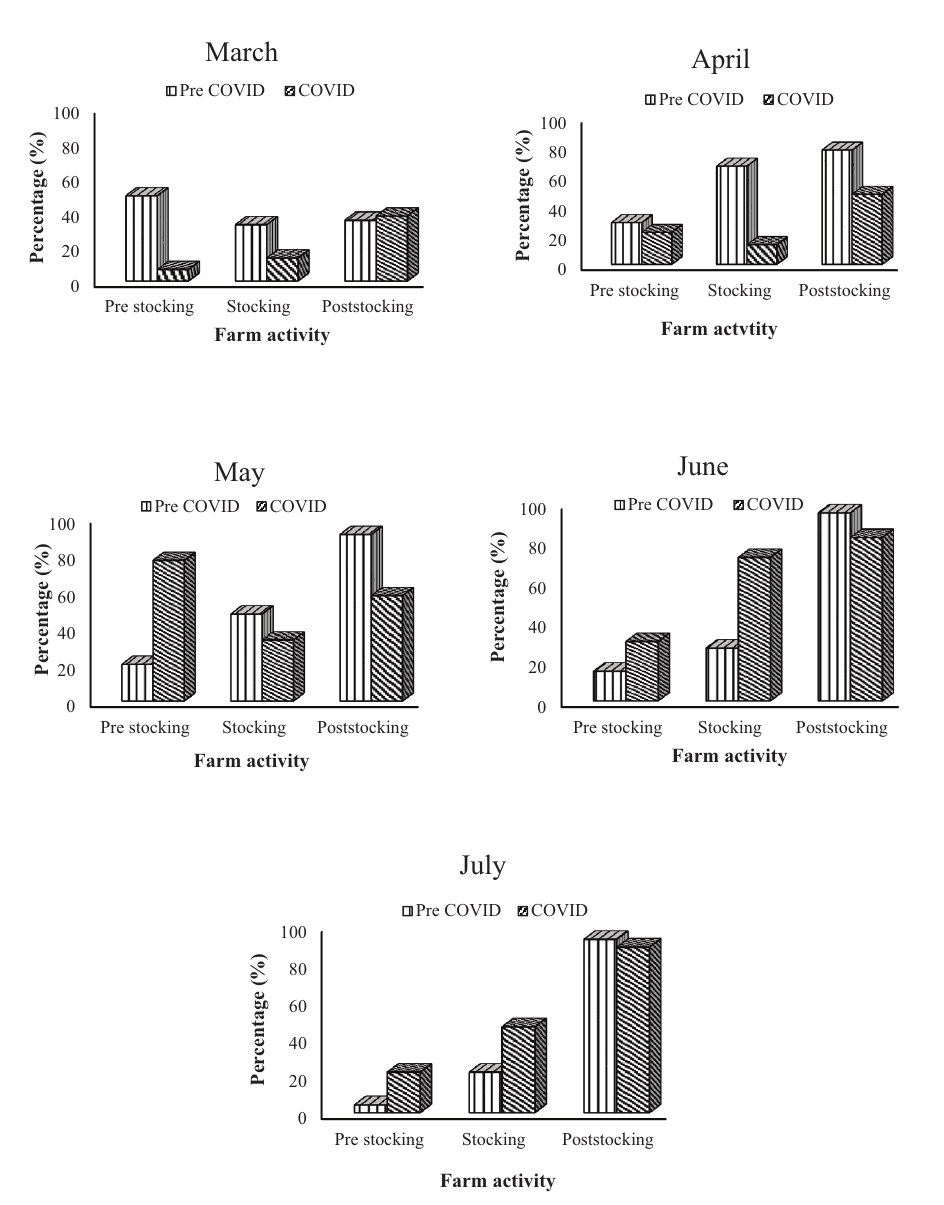
Fig. 6. Differential performance of farm activities during the Pre-COVID and COVID period in FW